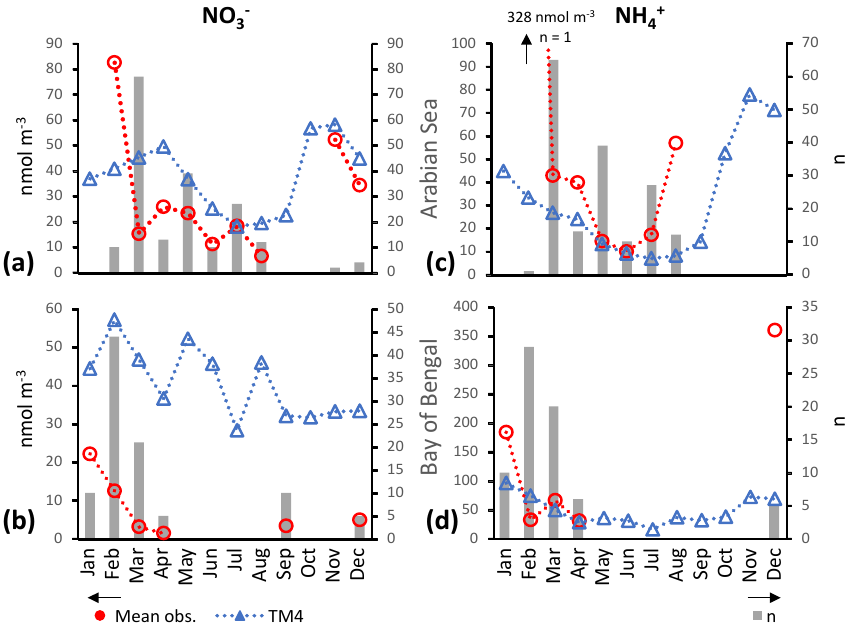
Figure 15. Monthly mean observed aerosol concentrations (red circles), simulated concentrations from TM4 (blue triangles) and total number of observations ( n ) in each month (bars) for NO −